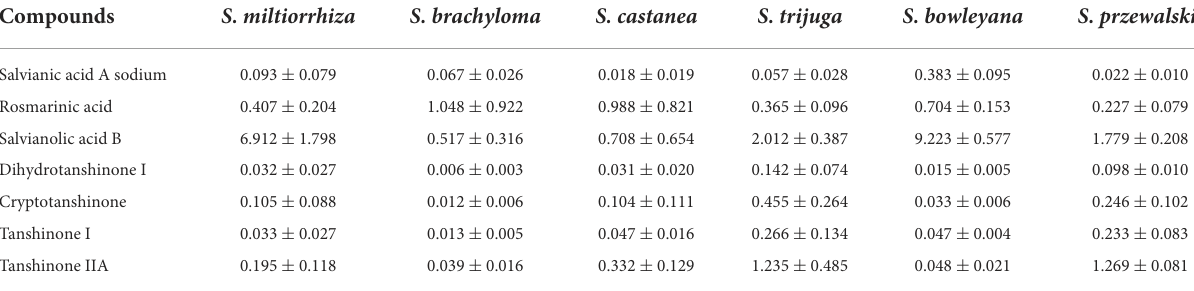
TABLE 2 The contents of seven active components in six Salvia species.